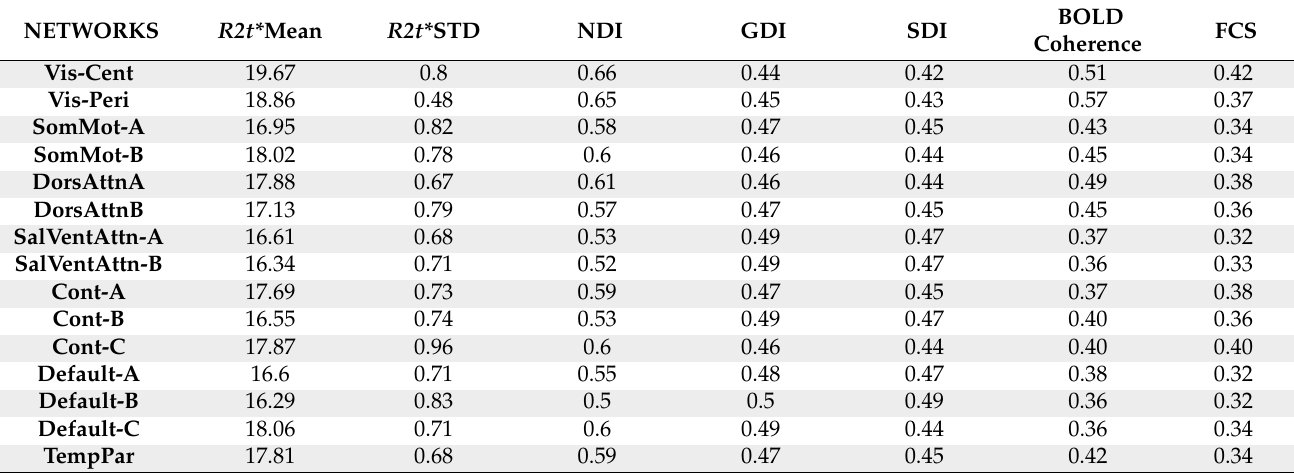
Table A1. Summary of R2t* and the cellular densities in the 15 networks. Columns 2 and 3 represent the mean and standard deviation of the R2t* distribution across 16 subjects (values are in 1/sec). Columns 4–6 represent the mean values of the neuronal, glia, and synaptic density indices (qGRE proxy for the neuronal (NDI), synaptic (SDI), and glia (GDI) cells’ densities). Data in columns 4–6 correspond to the maps in Figure 2 of the main text. Data in columns 7 and 8 represent the mean values of the BOLD signal coherence and functional connectivity strength (FCS) corresponding to the data in Figures 3 and 4 of the main